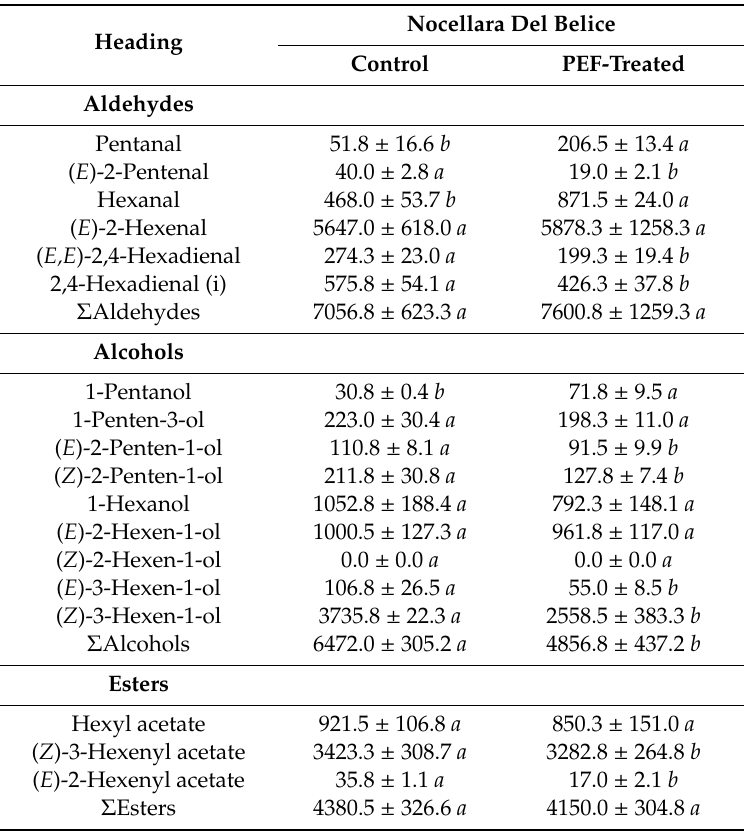
Table 4. Volatile compounds detected in EVOOs ( µ g /